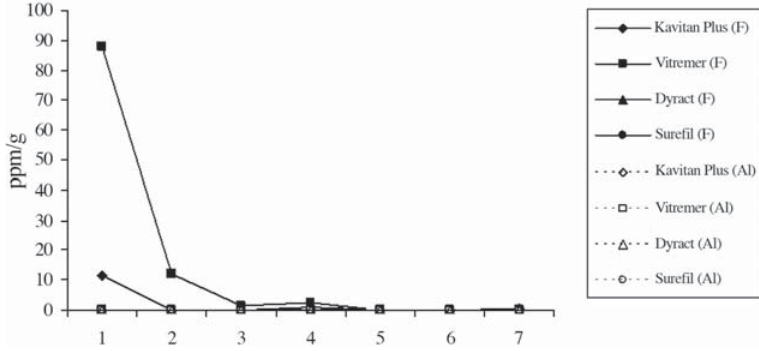
Figure 4- (cid:4)(cid:28)(cid:6)(cid:27)(cid:18)(cid:24)(cid:9)(cid:16)(cid:14)(cid:4)(cid:7)(cid:10)(cid:16)(cid:4)(cid:7)(cid:6)(cid:27)(cid:17)(cid:9)(cid:10)(cid:27)(cid:17)(cid:4)(cid:24)(cid:14)(cid:6)(cid:14)(cid:7)(cid:21)(cid:14)(cid:16)(cid:4)(cid:29)(cid:24)(cid:18)(cid:17)(cid:4)(cid:14)(cid:7)(cid:8)(cid:13)(cid:4)(cid:17)(cid:7)(cid:12)(cid:14)(cid:24)(cid:9)(cid:7)(cid:6)(cid:4)(cid:9)(cid:10)(cid:4)(cid:7)(cid:24)(cid:12)(cid:9)(cid:15)(cid:8)(cid:9)(cid:7)(cid:6)(cid:4)(cid:21)(cid:7)(cid:6)(cid:9)!(cid:7)(cid:4)(cid:16)(cid:27)(cid:24)(cid:9)(cid:10)(cid:11)(cid:4)(cid:12)(cid:13)(cid:14)(cid:4)(cid:15)(cid:24)(cid:21)(cid:12)(cid:4)(cid:30)(cid:4)(cid:16)(cid:7)(cid:3)(cid:21)